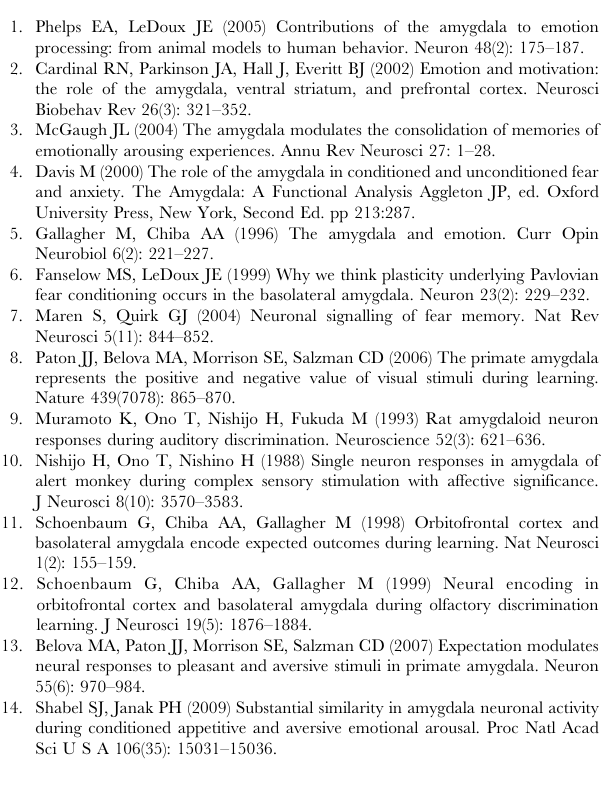
Figure S2 Movement during fear CS during condition- ing sessions. There was an increase in movement, on average, during the fear CS, reflecting the escape/fleeing-like reactions that occurred during the conditioning sessions (n= 39 sessions). Figure S3 Baseline firing rates and spike durations of fear CS-responsive cells. Cells with increases in activity during the fear CS had, on average, higher baseline firing rates and smaller spike widths. (EPS) Text S1 Changes in blood pressure, heart rate, and movement do not account for valence